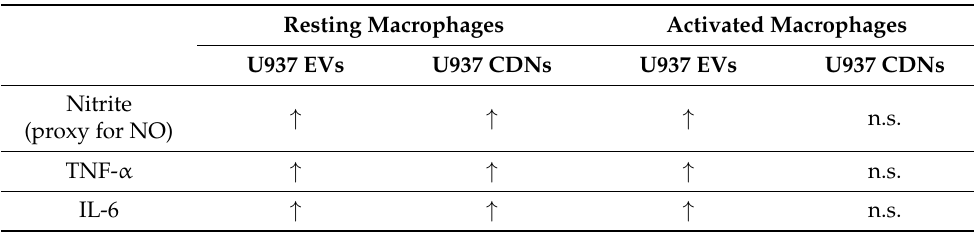
Table 1. Summary of the inflammatory properties of U937 EVs and U937 CDNs on resting and LPS-stimulated activated